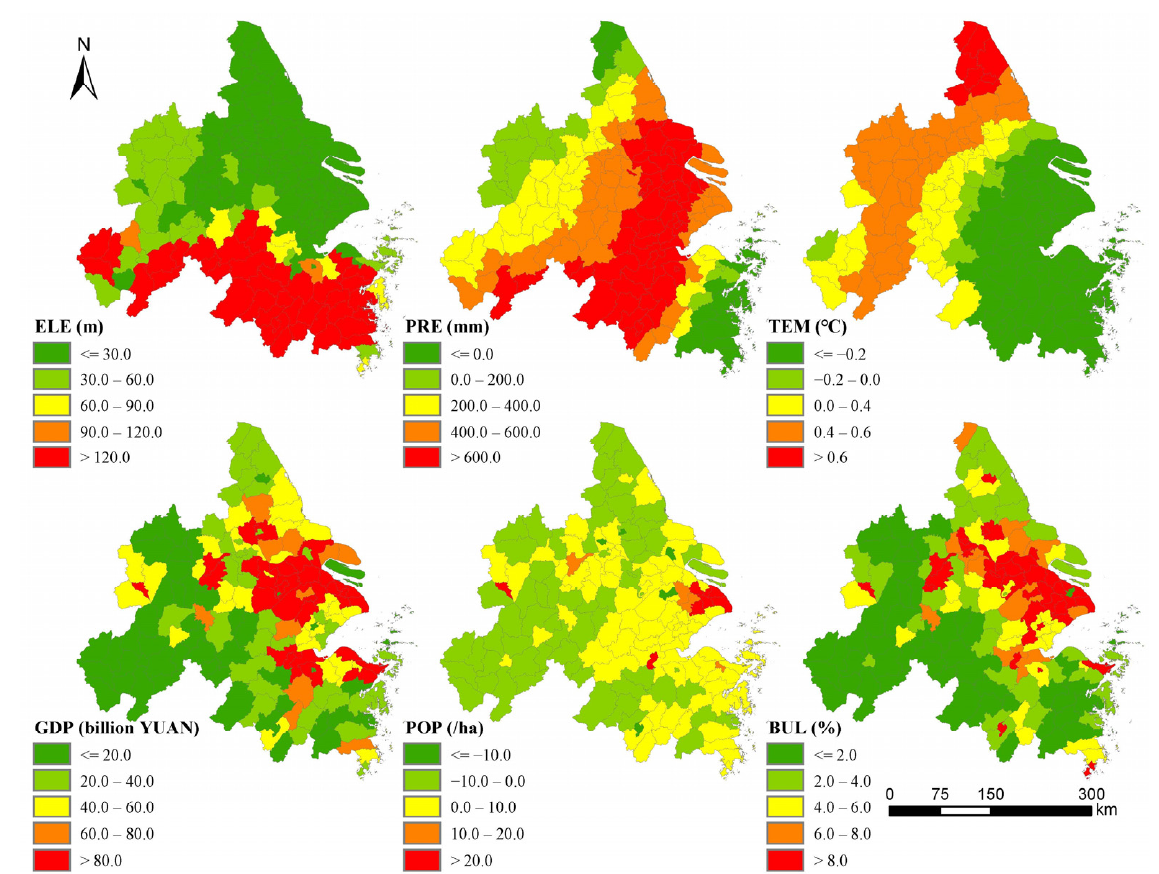
Figure 3. The spatial distribution of potential influencing factors (ELE: elevation, PRE: changes in annual average precipitation, TEM: changes in annual average temperature, GDP: changes in gross domestic product, POP: changes in population density, BUL: changes in the proportion of built-up land).